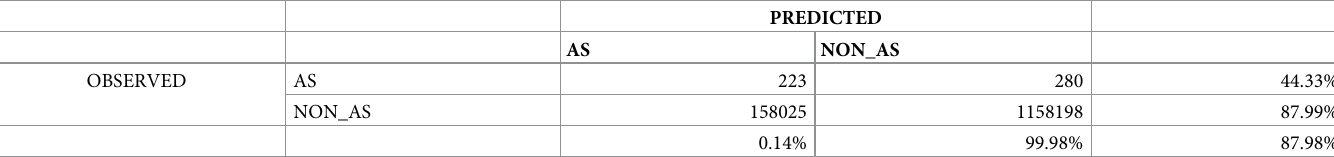
Table 6. Female excluding training and testing data.